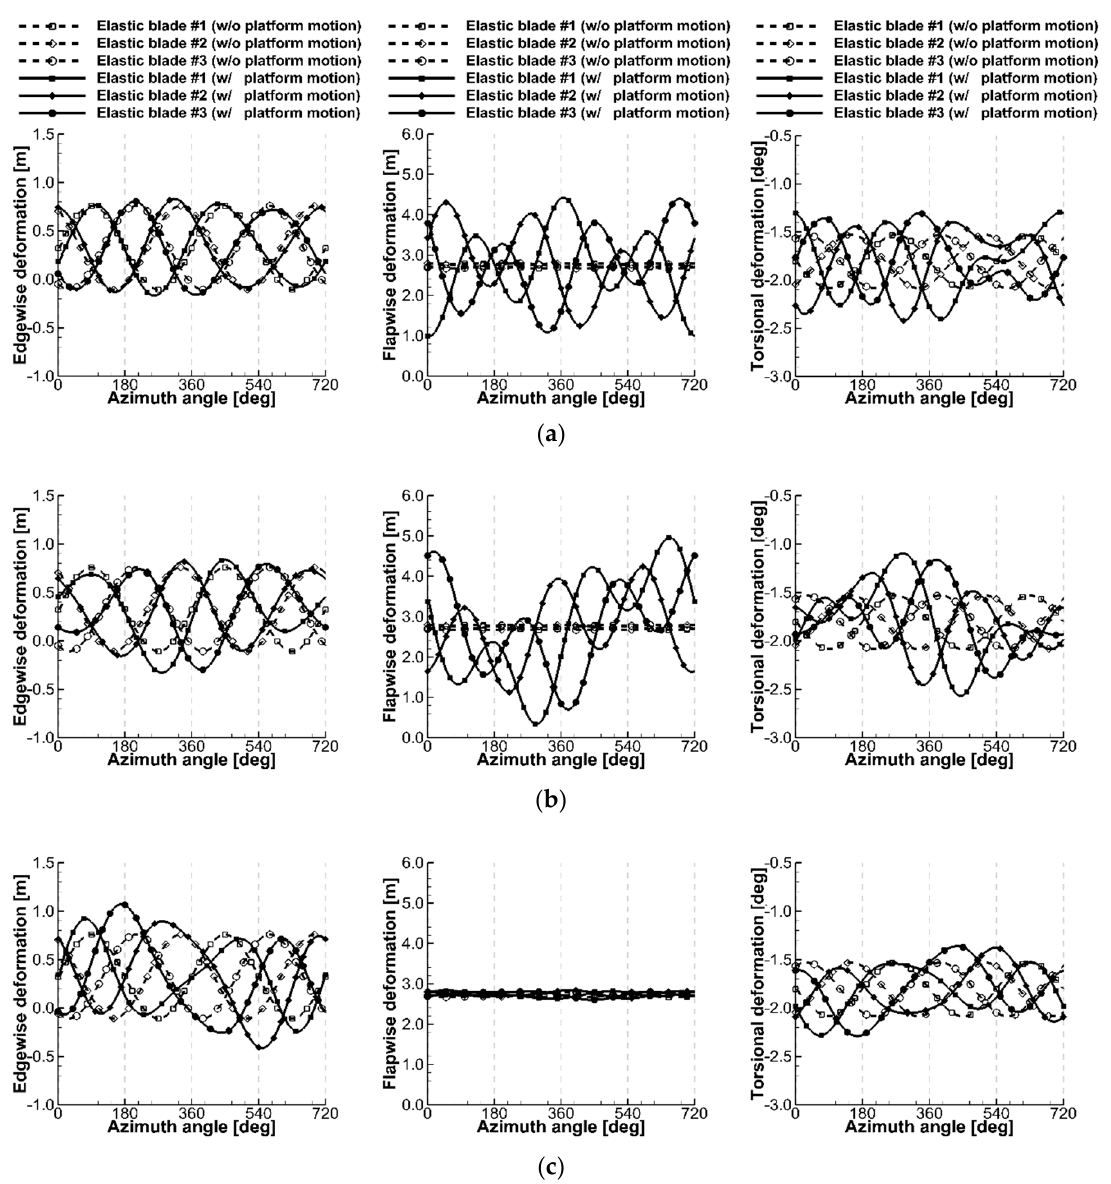
Figure 14. Blade tip deformations under rotational platform motions. ( a ) Yaw motion . ( b ) Pitch motion . ( c ) Roll motion .